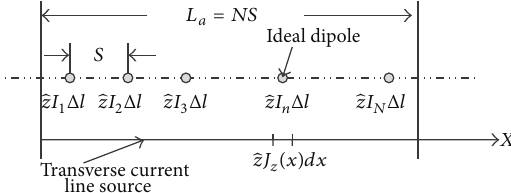
Figure 3: Ideal dipole array and transverse current line source